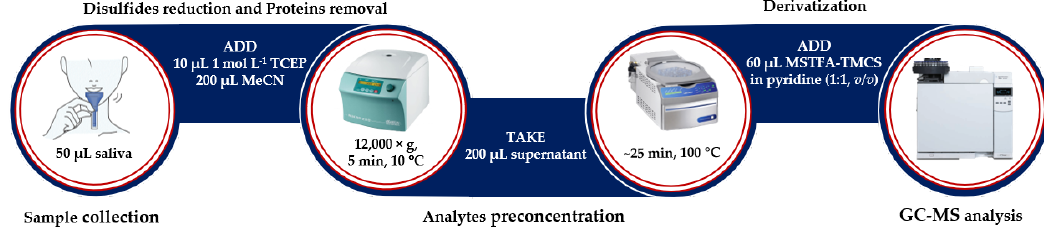
Figure 6. The experimental procedure for HTL, Met, Cys, and Hcy simultaneous determination in human saliva (see Section 3.5).